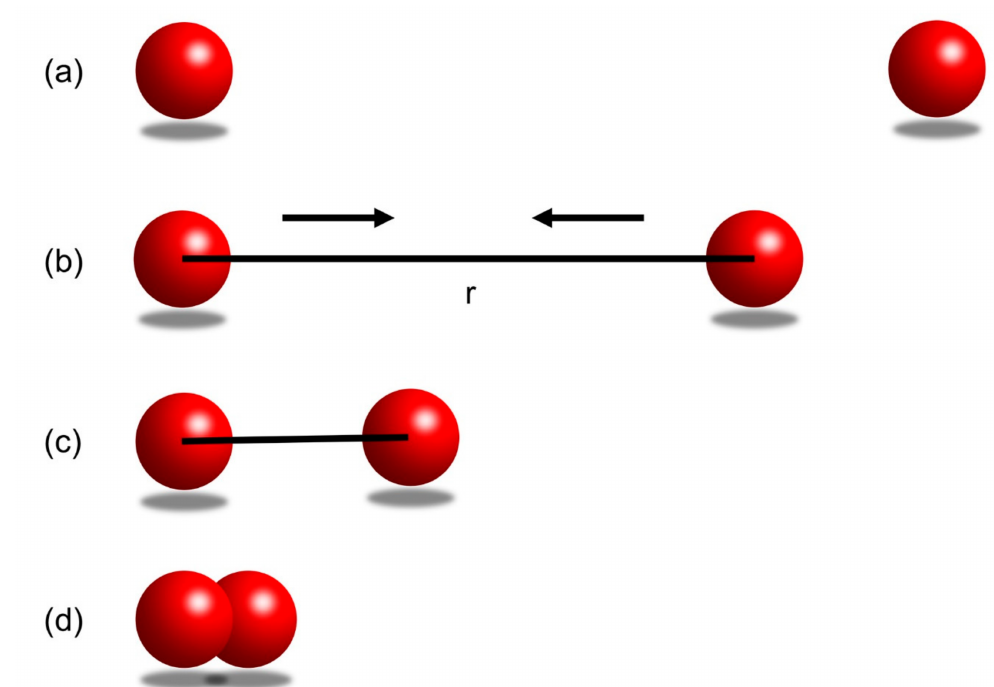
Figure 8. ( a ) The balls are not interacting as they have an infinite distance. ( b ) Two balls are brought closer with minimum energy to a distance of r. The two balls have an attractive force between them. ( c ) The two balls are brought closer by the attractive force between them until they reach an equilibrium distance, at which they reach the sminimum bonding potential. ( d ) External energy pushes the two balls even closer. A repulsive force tries to push the two balls apart, and the repulsive force is greater than the attractive